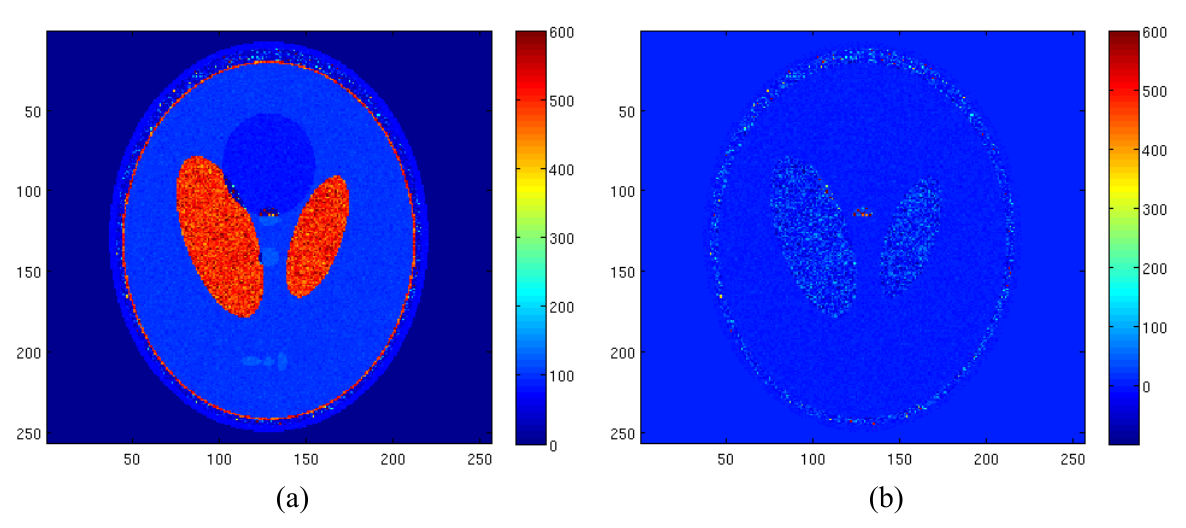
map using LS estimator with Gaussian complex model in case of Figure 9. Estimated T 2 reconstruction error map (Normalized mean square error equal to 0.0210)  = 1.5 (a), T 2